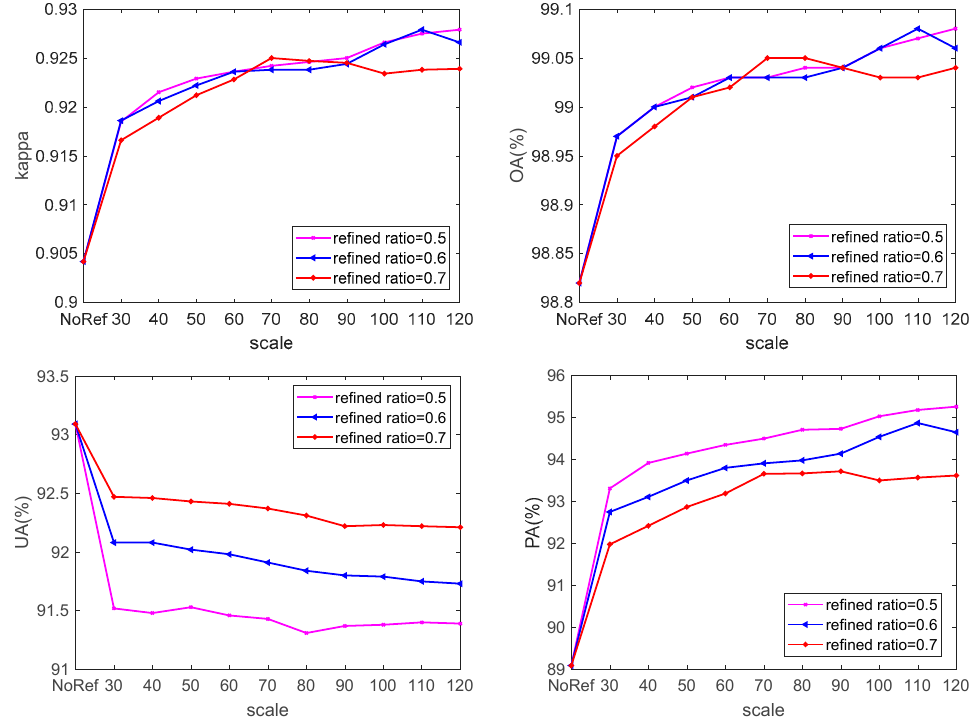
Figure 9. TRS_LM_RGA-based classification refinement results using the VV image under different scales and refined ratios. NoRef refers to water detection without classification refinement.